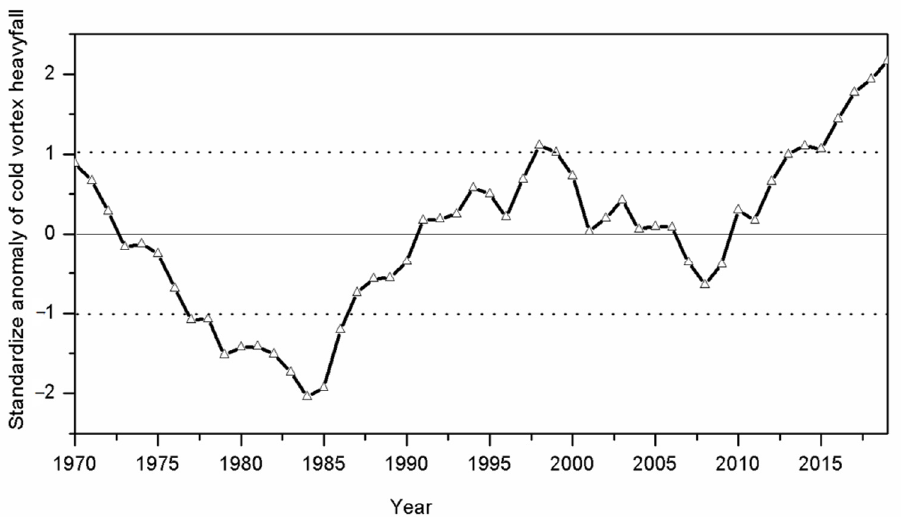
Figure 3. Interdecadal variability in heavy rainfall under cold vortex over northeast China during 1961–2019.